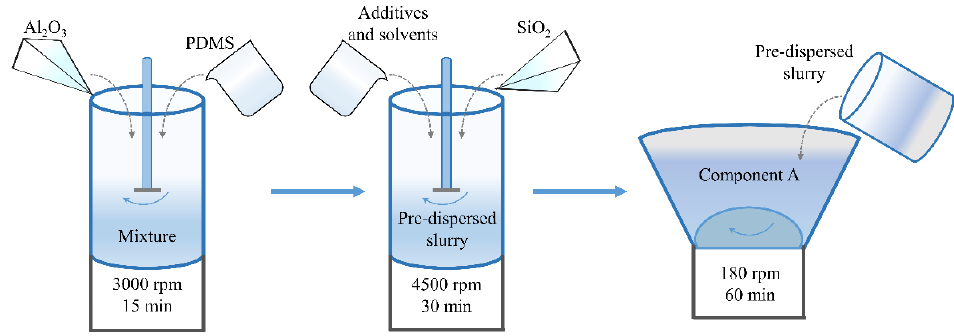
Figure 1. Schematic diagram of preparation process for component A of silicone topcoat.